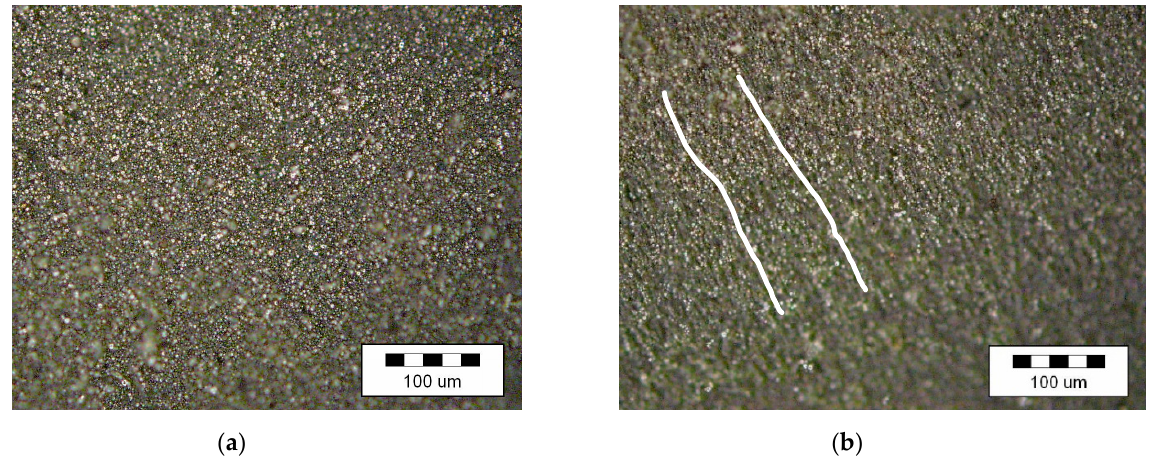
Figure 7. Internal structure of MAE samples with a filling agent content of 70%: ( a ) isotropic structure; ( b ) anisotropic structure.